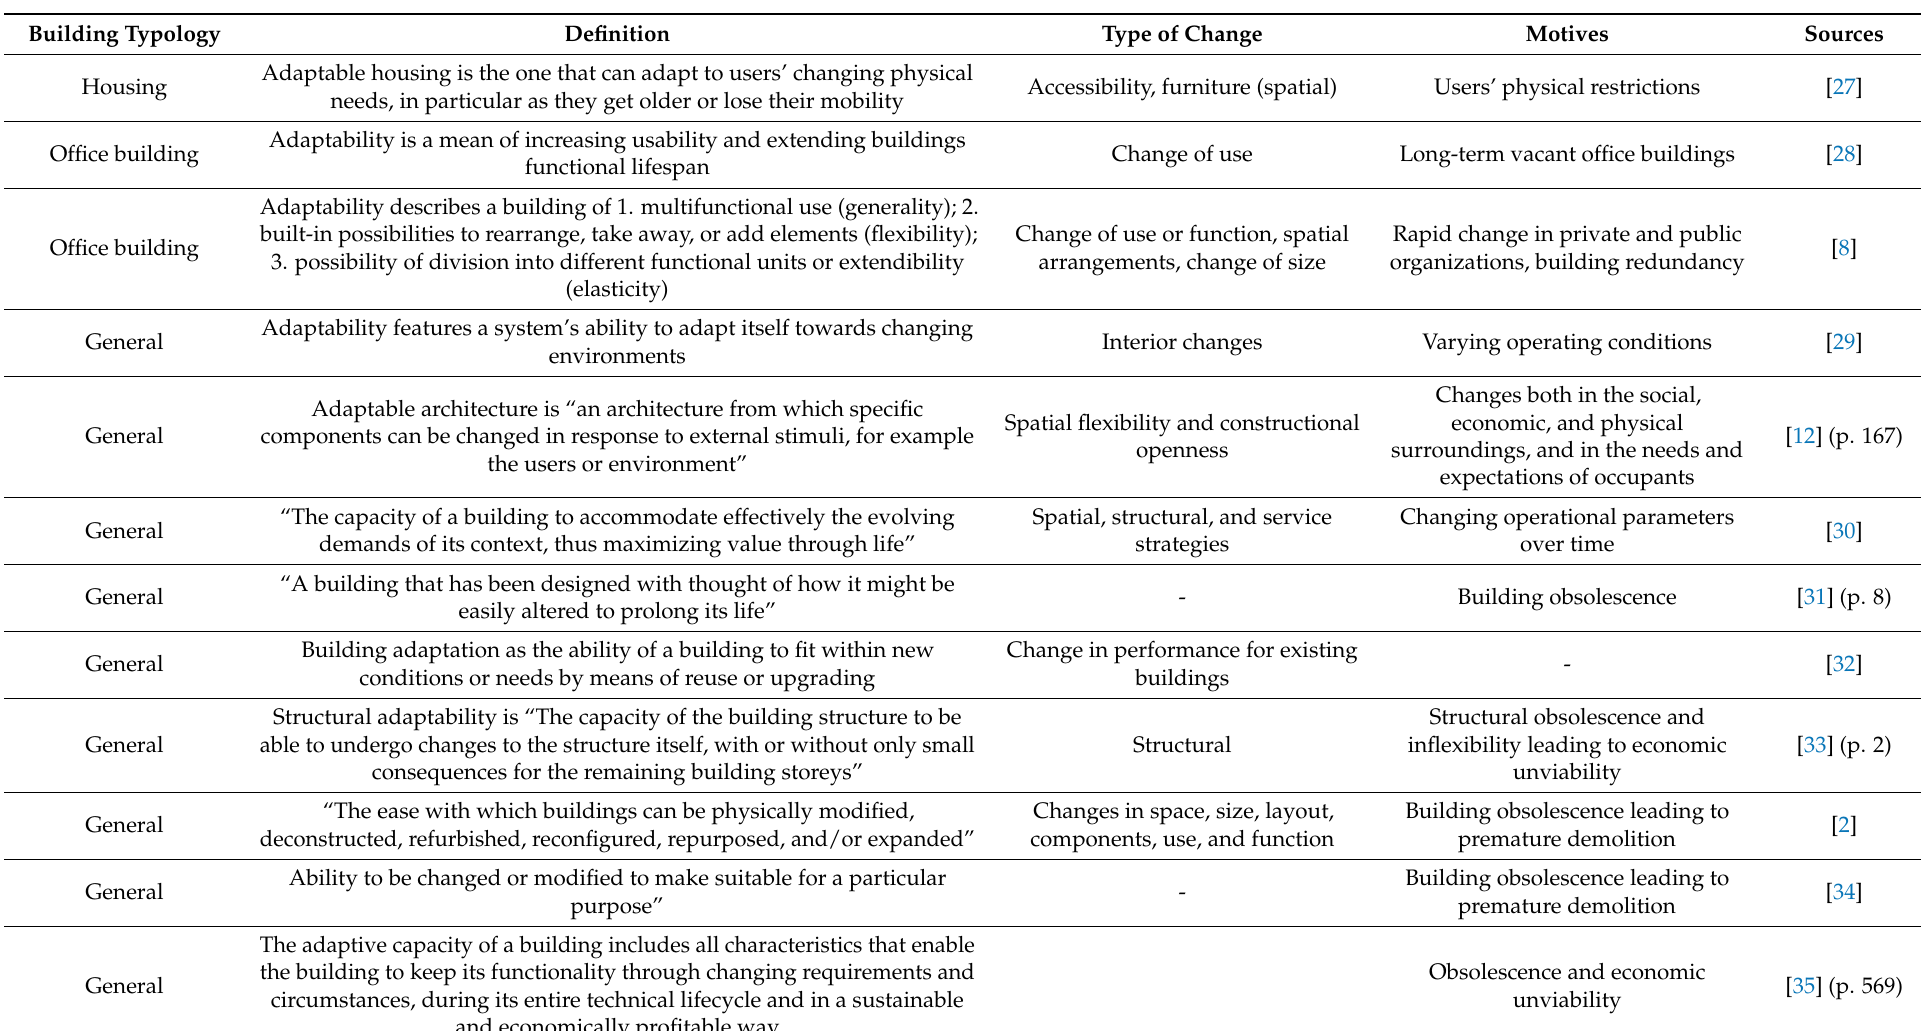
Table 4. Adaptability